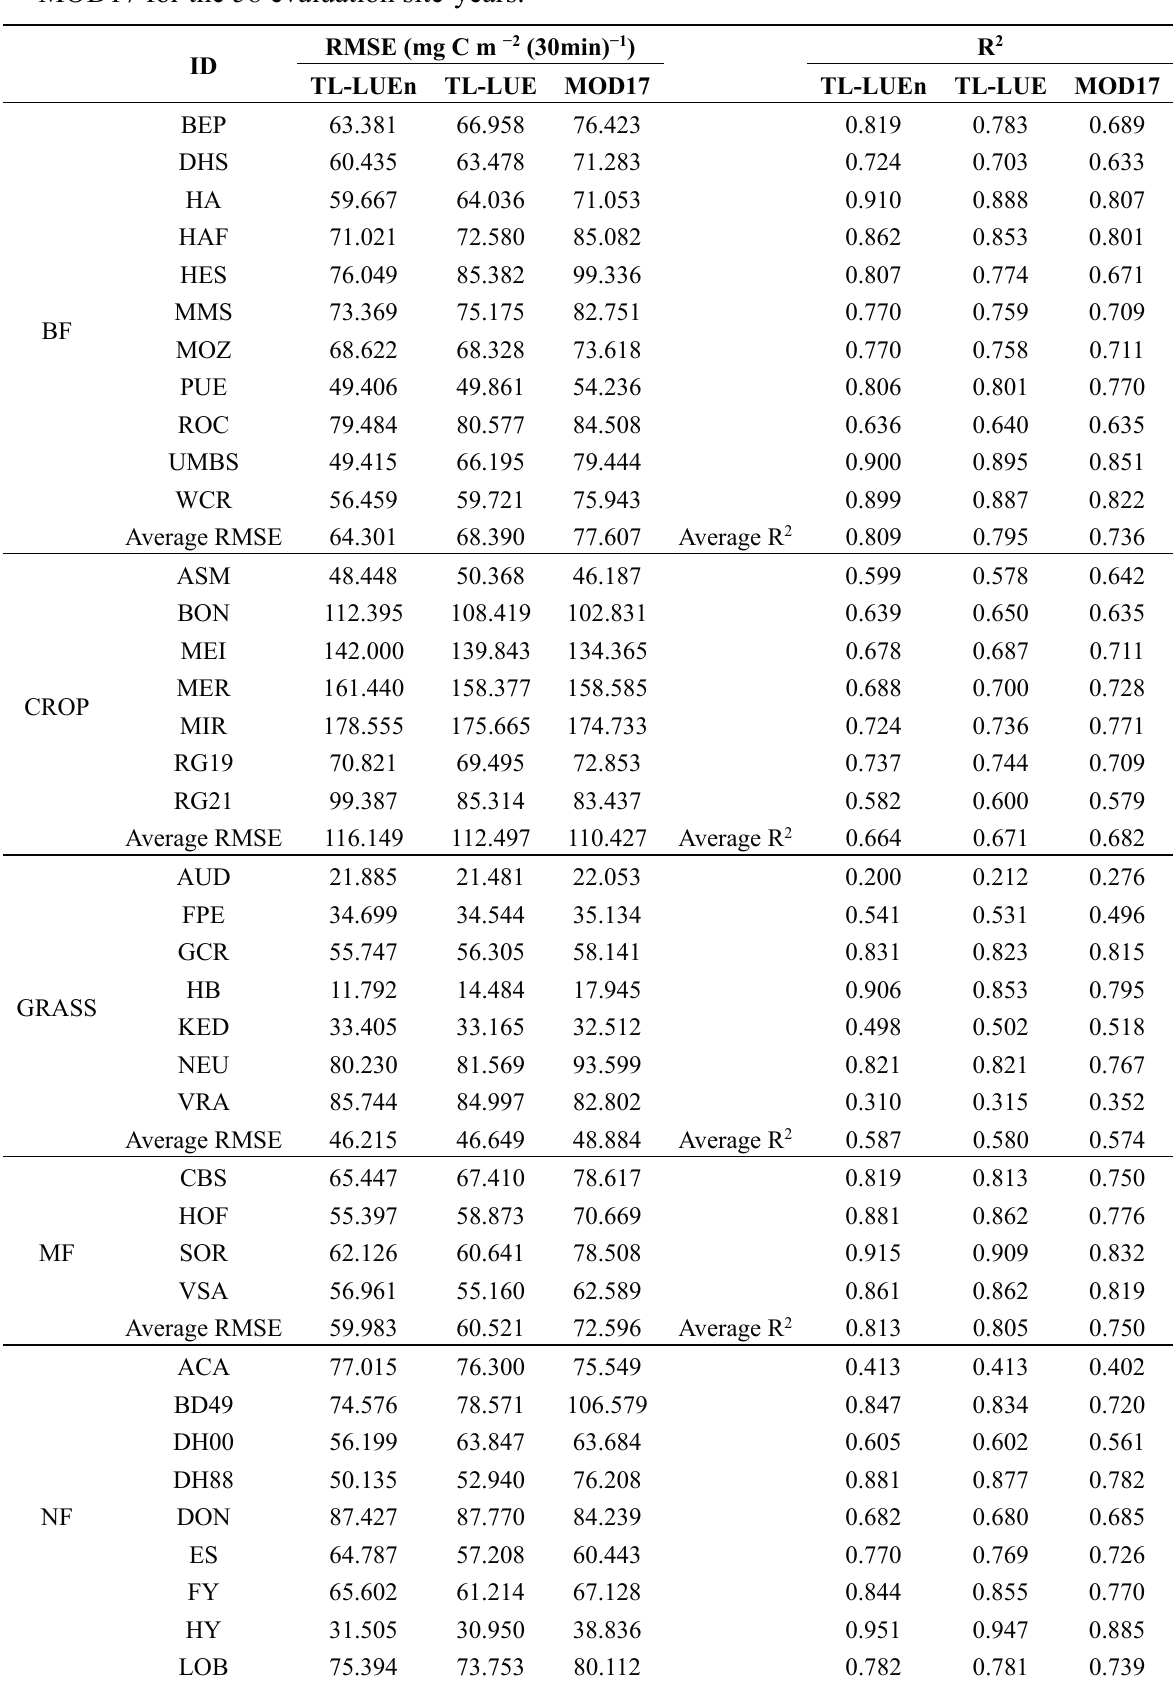
Table A1. Assessment of half-hourly GPP simulated using TL-LUEn, TL-LUE and MOD17 for the 58 evaluation